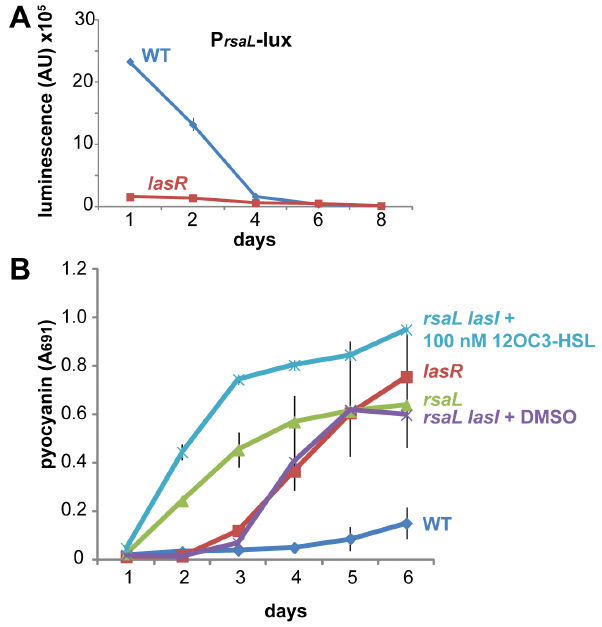
Figure 4. RsaL prevents pyocyanin production by stationary- phase lasR + cells. A. Transcription from the rsaL promoter in wild-type (PA14) and lasR mutant cells in static 25 u C LB culture. B. Pyocyanin quantification in static LB cultures of the listed strains and conditions at 25 u C. All plots show the mean 6 standard deviation of 3 biological replicates.